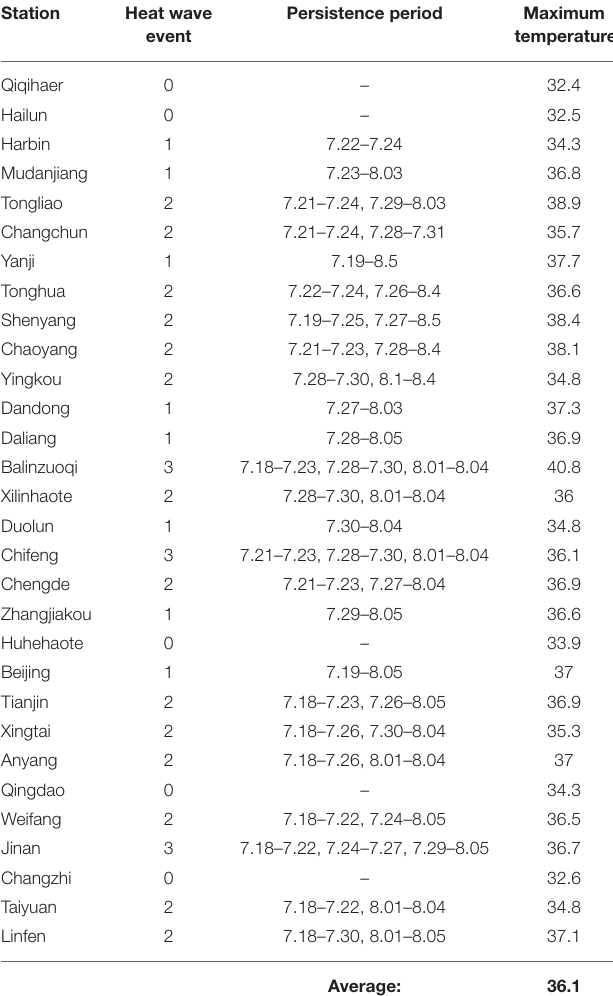
TABLE 1 | Showing the statistics of heat wave events (July 18th to August 5th). Station